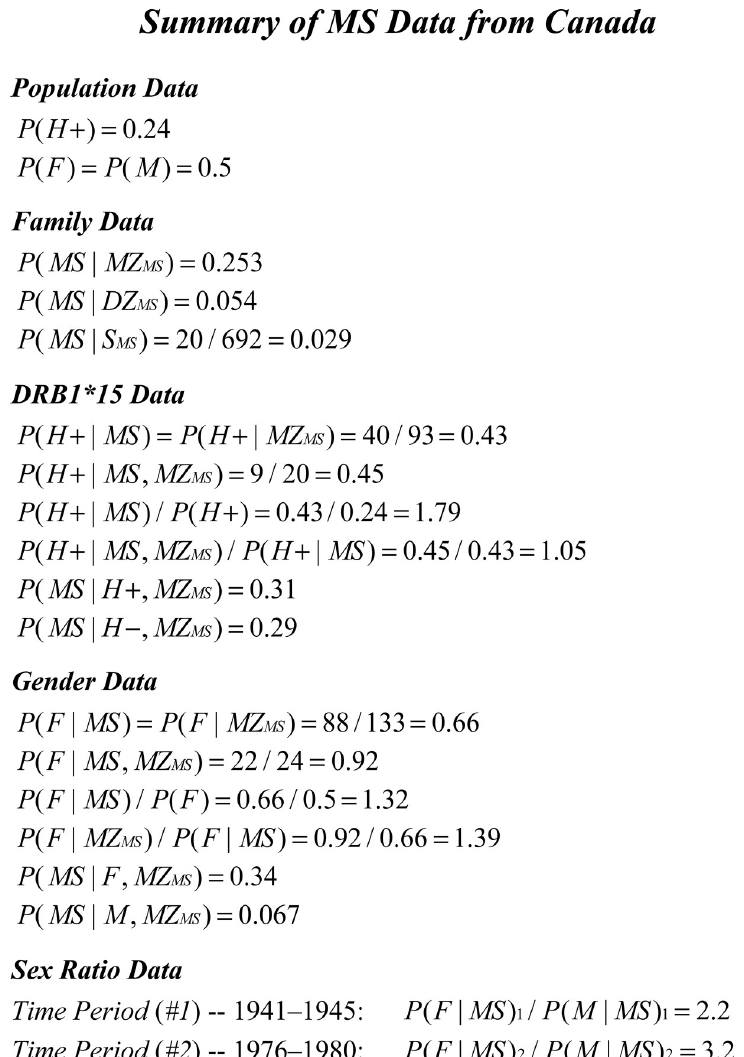
Fig 3. Summary of epidemiological data regarding MS in Canada circa 2000–2010. The value for P ( H+ ) was provided by D. Sadovnick, was based on 400 Canadian controls, and the rate was confirmed in a large transplant database ( personal communication ). The F : M sex-ratio in the general population of Canada was taken from the 2010 Canadian census. Recurrence risks for monozygotic ( MZ ) twins, dizygotic ( DZ ) twins, and siblings ( S ) were taken from the study of Willer et al. [29]. The other summary data was taken from Table 3 , and/or from the study of Willer et al. [29]. The F : M sex-ratio among Canadian MS patients at each of the 5-year time-periods (1941–1945 & 1976– 1980) was taken from the study of Orton et al.